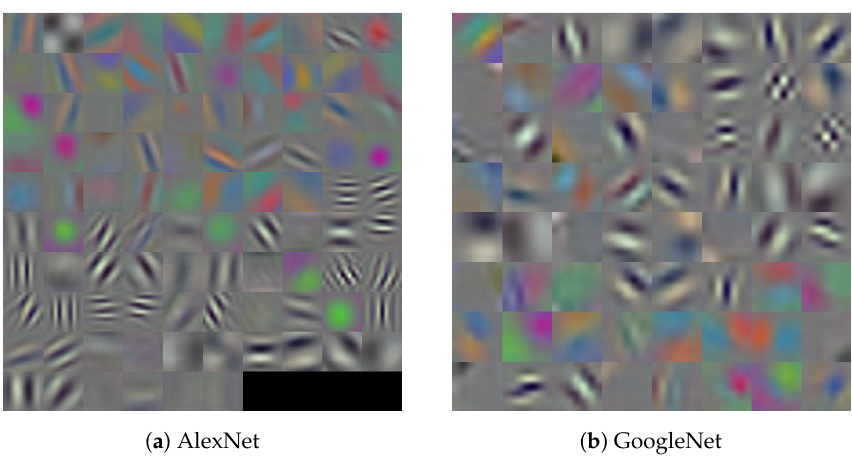
Figure 11. Filters learned by pre-trained models in the first convolutional layer.